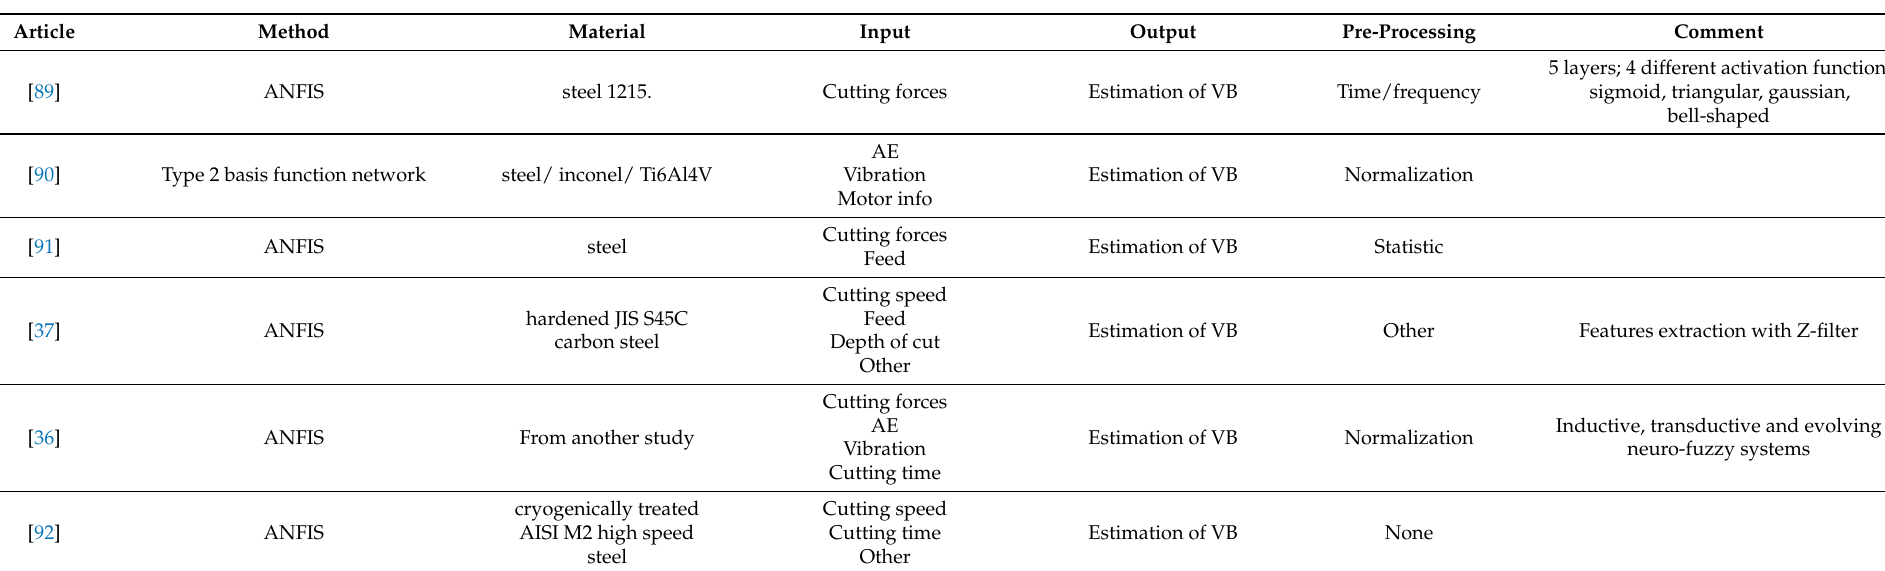
Table A3. General summary of neuro-fuzzy related